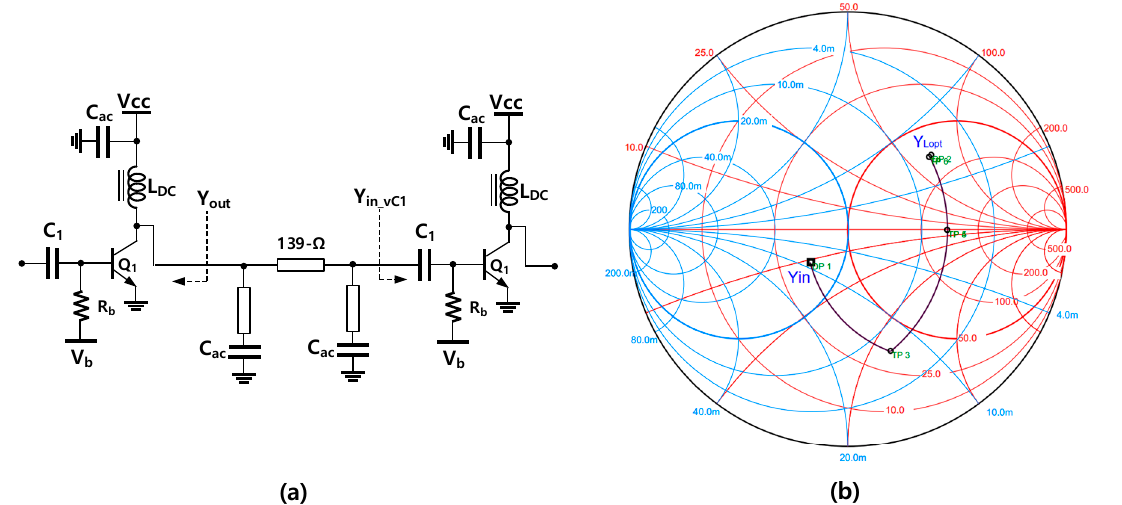
Figure 7. Circuit structure for interstage impedance matching ( a ) and impedance transformation using on smith chart ( b ).